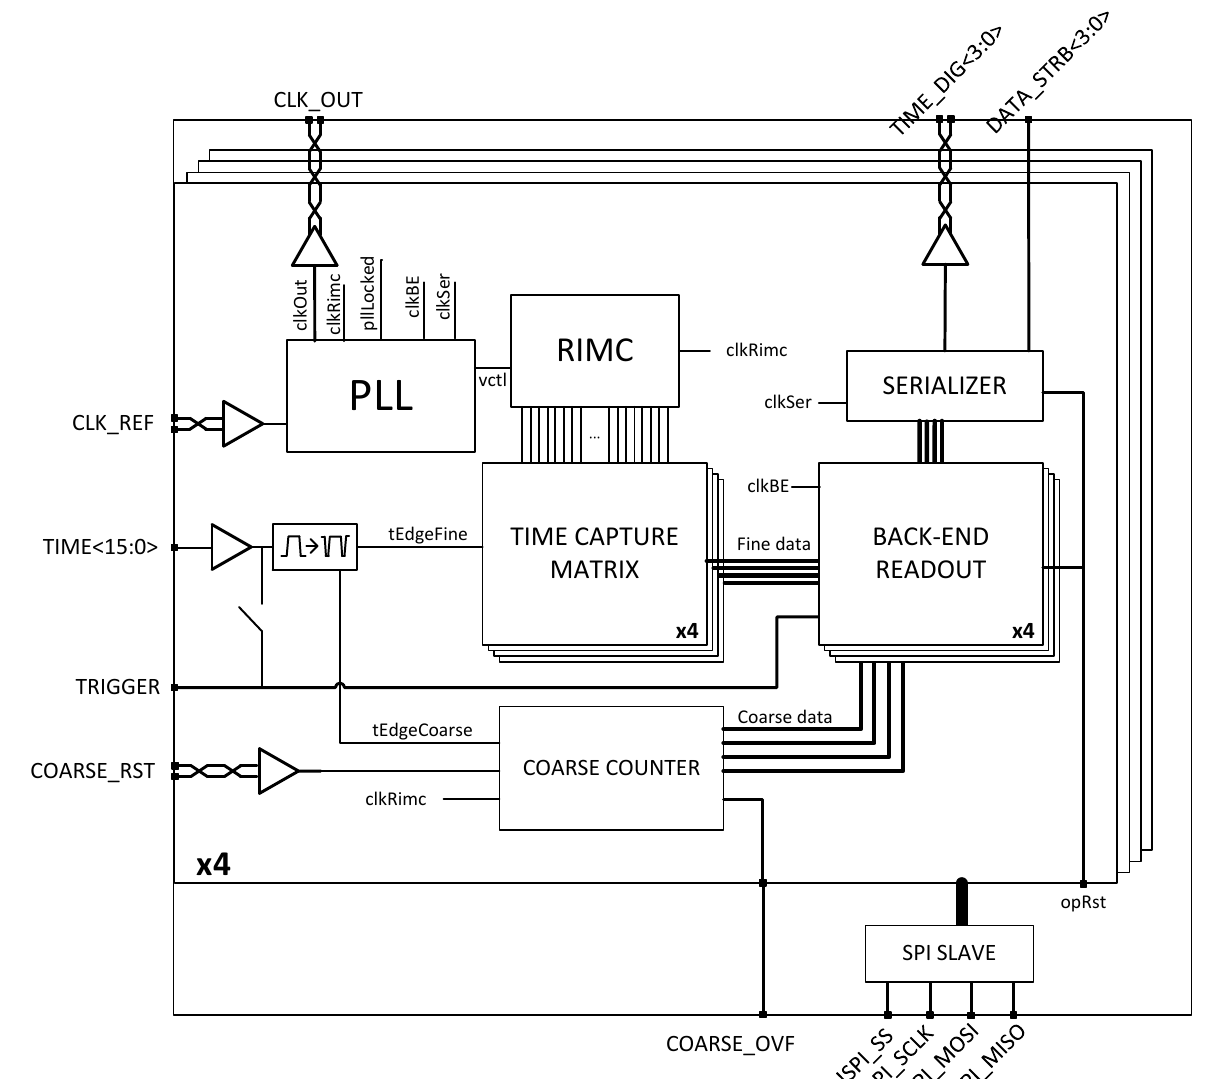
Figure 1. Block diagram of MATRIX16.